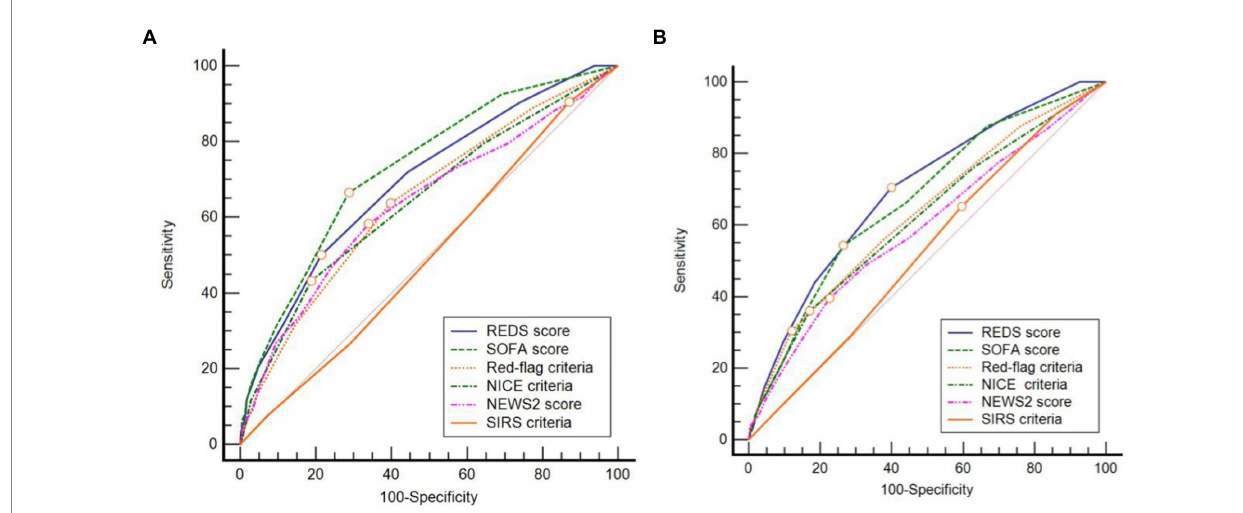
FIGURE 3 Receiver operator characteristic curves for (A) in-hospital and (B) 180 day mortality. REDS, Risk-stratification of Emergency Department suspected Sepsis; SOFA, Sequential Organ Failure Assessment; NICE, National Institute for Health and Care Excellence; NEWS2, National Early Warning Score 2; SIRS, Systemic Inflammatory Response